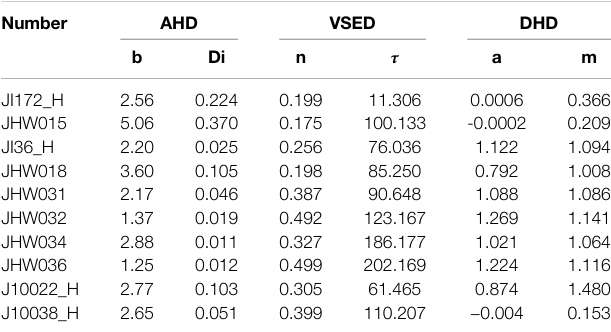
TABLE 5 | Fitting parameters of 10 typical horizontal